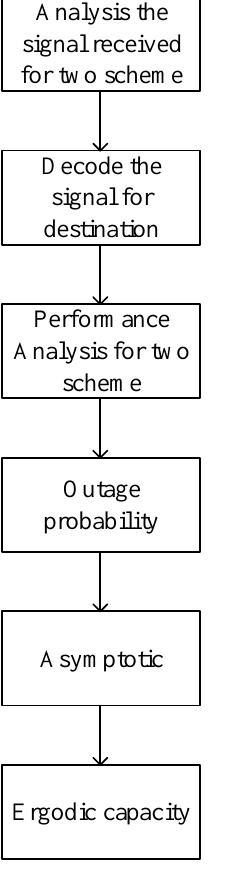
Figure 3. The flowchart to calculate the main system metrics for the RIS-T